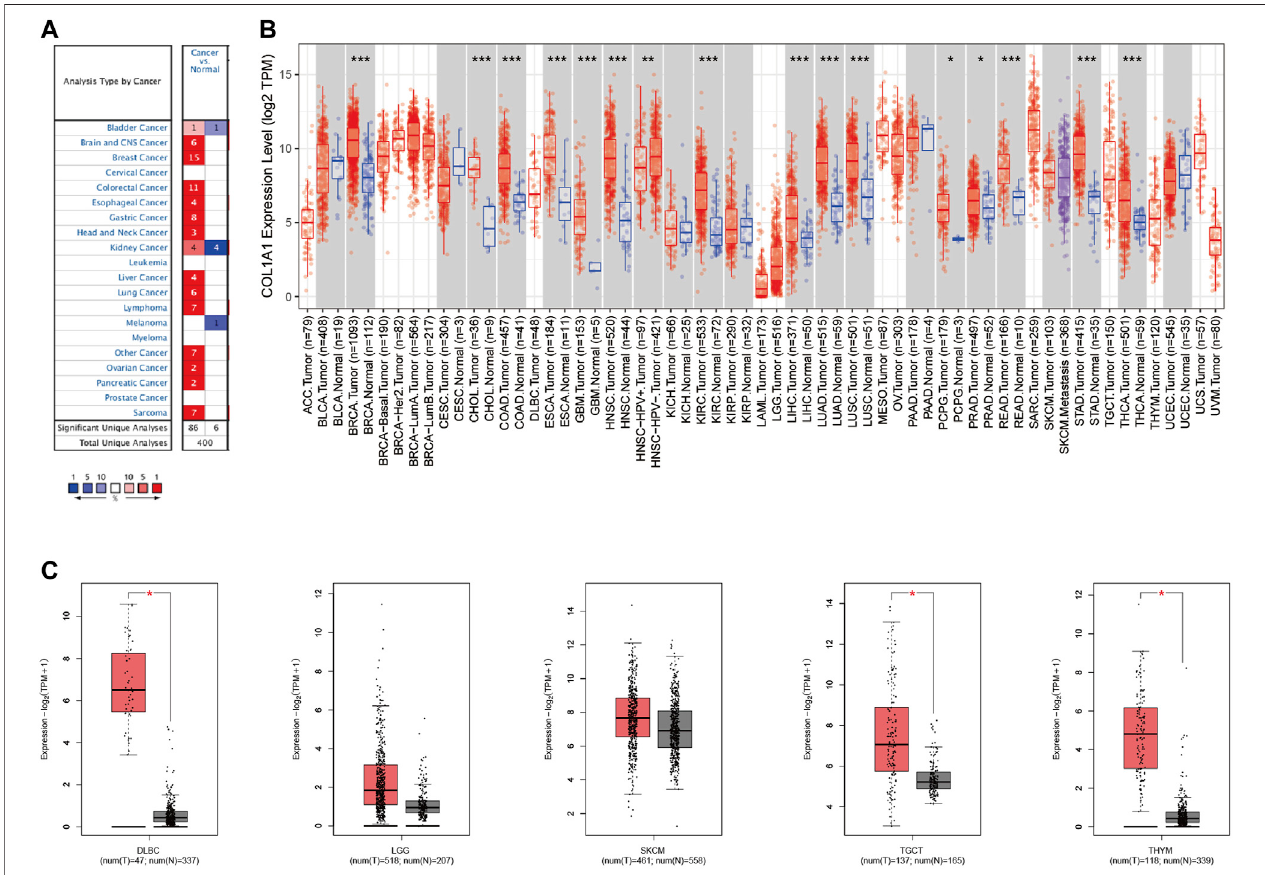
FIGURE 2 | (A) COL1A1 expression levels in diverse cancer types and normal tissues by Oncomine. The red color represents increased expression and the blue color represents decreased expression of COL1A1 in different cancers compared with normal tissues. (B) COL1A1 expression in diverse cancers relative to the non- carcinomatissuesamplesbasedontheTCGAdatabasethroughTIMER2.* p < 0.05;** p < 0.01;*** p < 0.001. (C) COL1A1 expressioninDLBC,LGG,SKCM,TGCT,and THYM by GEPIA2. * p <